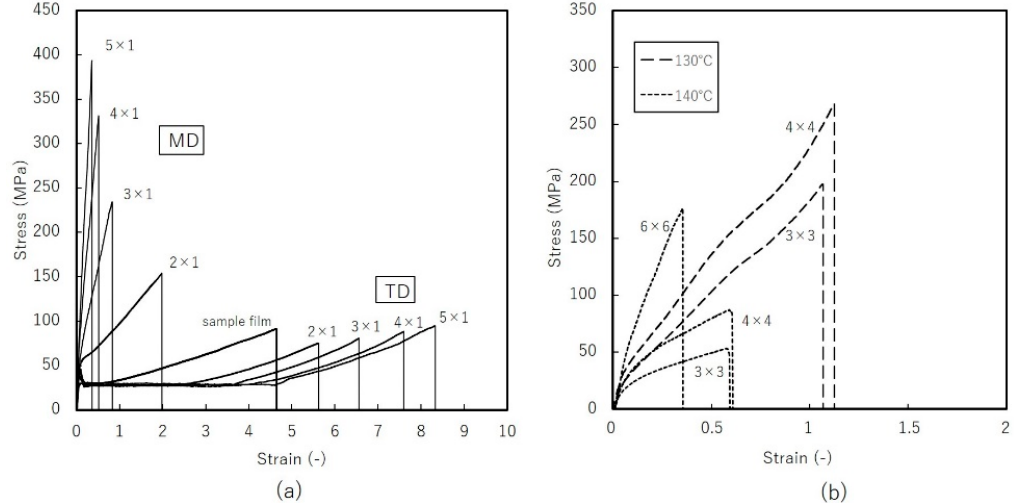
Figure 15. Tensile test results of: ( a ) uniaxial constrained-width stretched films at 120 °C ( b ) simultaneous biaxially stretched films at 140 °C with stretching speed of 1 m/min.